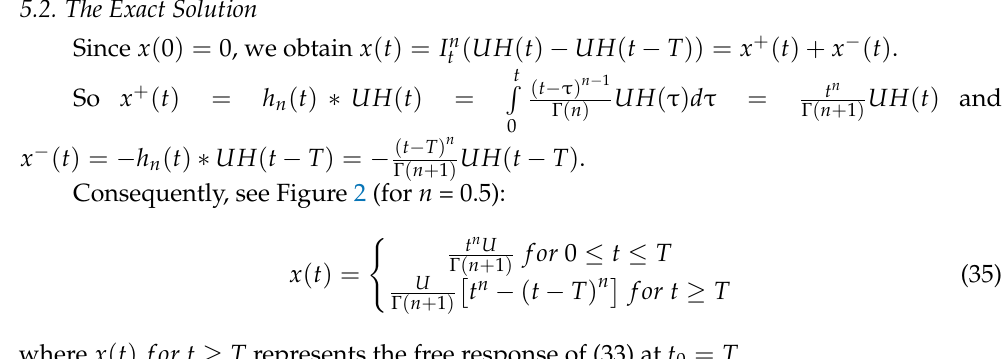
Figure 2. True free response and Caputo derivative initialization for n = 0.5.